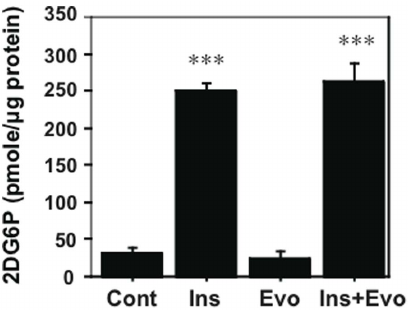
Figure 7. Effect of evodiamine and insulin on glucose uptake in differentiated adipocytes. After 3T3-L1 pre-adipocytes were differ- entiated into mature adipocytes, the cells were maintained in DMEM for 6 h and then stimulated by 20 nM insulin or 20 m M evodiamine alone, or in combination with insulin and evodiamine for 40 min and with 1 m M 2DG for the last 20 min. The 2DG6P content in each cell sample was measured by using glucose uptake colorimetric assay kit. Data are expressed as mean 6 SEM ( n =3–4). *** p , 0.001 vs. control group without